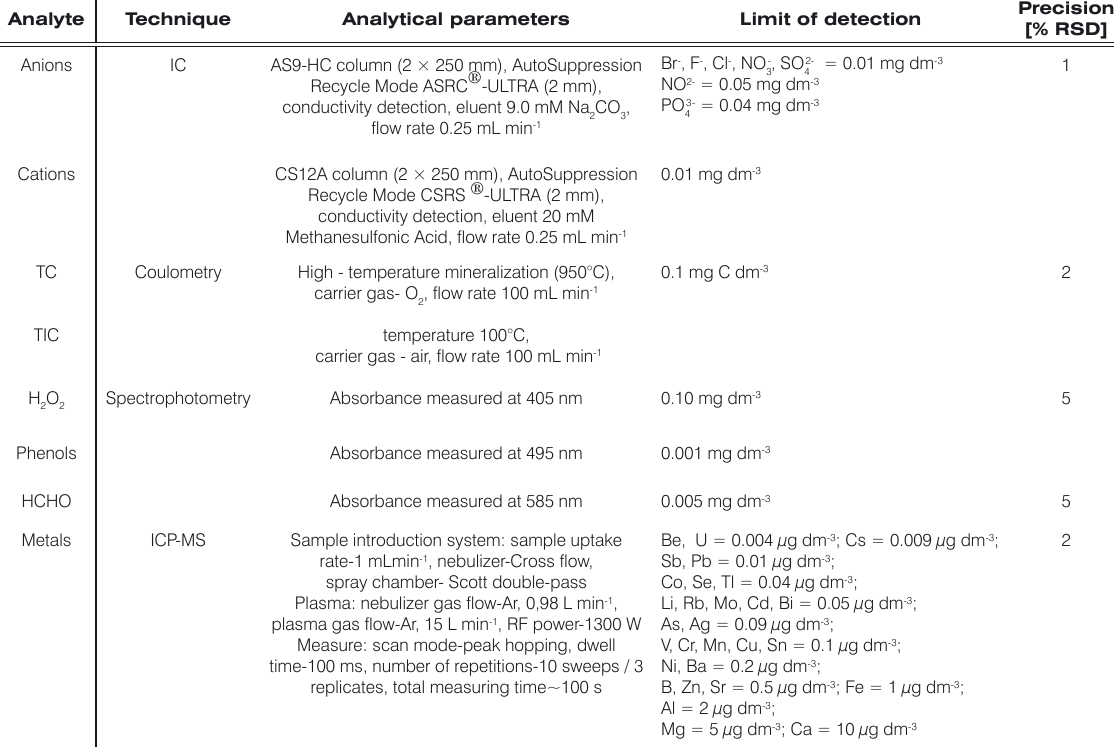
Table 2. The characteristics of the analytical techniques used in the